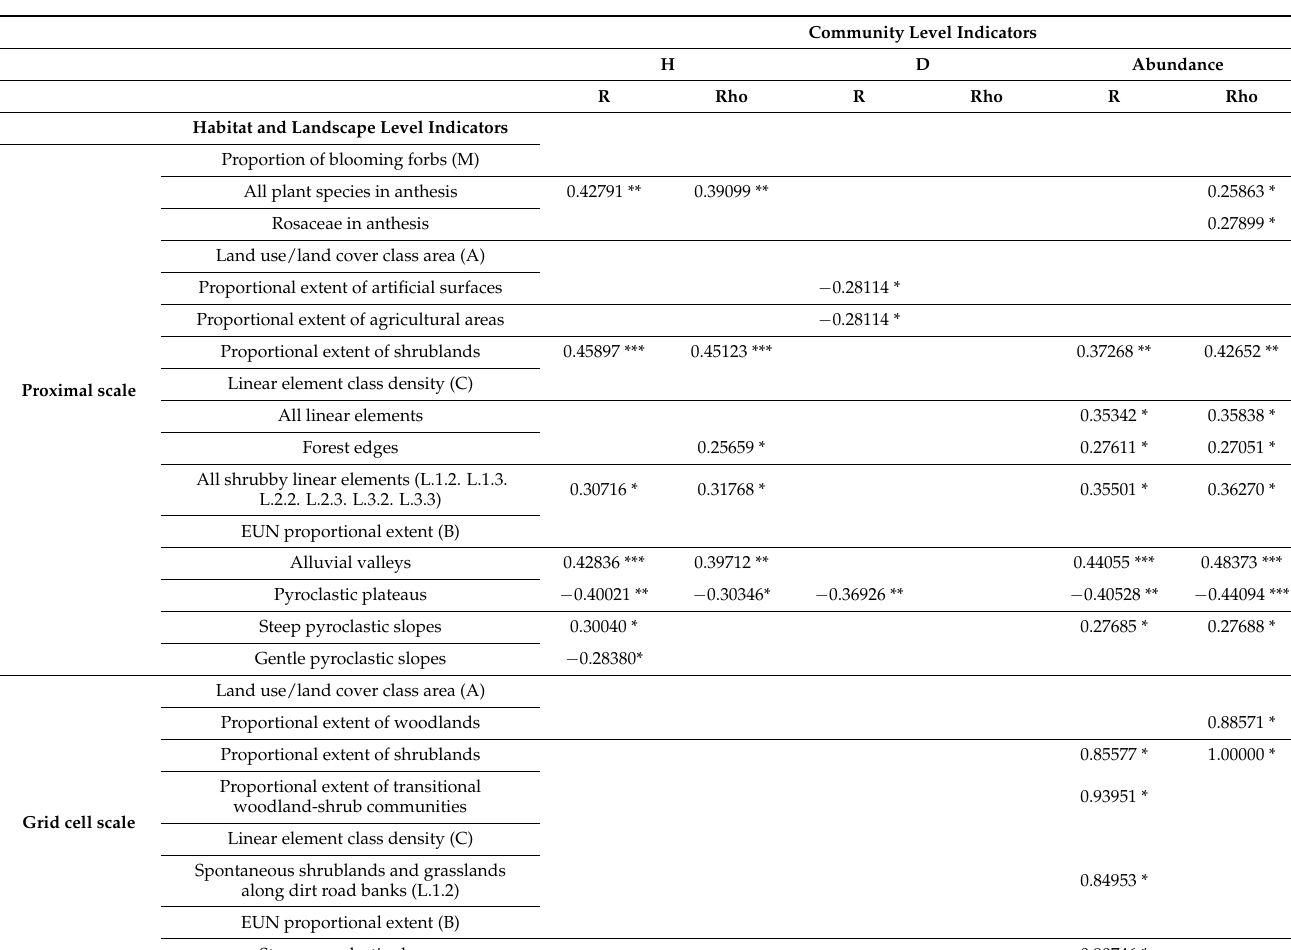
Table 5. Significant correlations emerged between community level indicators (bee abundance and diversity) and habitat and landscape level indicators, at the proximal scale and at the grid cell scale. D = Simpson Index; H = Shannon Index. Levels of significance are: * = p -value < 0.05; ** = p -value < 0.005; *** = p -value <